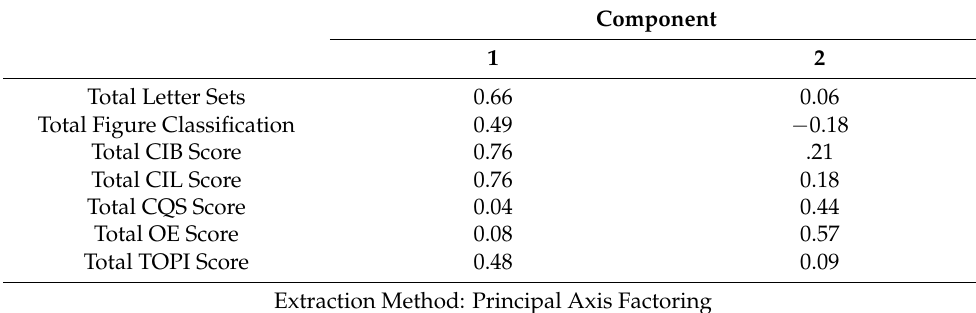
Table 6. Rotated Principal—Factor Matrix: Psychometric assessments, Cultural Intelligence Tests— Business (CIB), Cultural Intelligence Tests—Business (CIL), Cultural Intelligence Scale (CQS), Open- ness to Experience (OE), and Test of Personal Intelligence